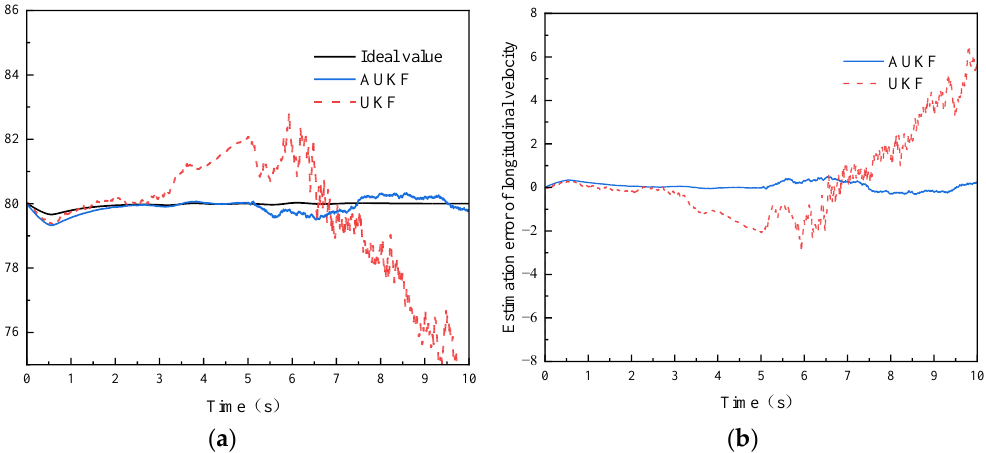
Figure 8. Simulation results of longitudinal velocity. ( a ) Comparison of estimated results and ( b ) comparison of estimated error.